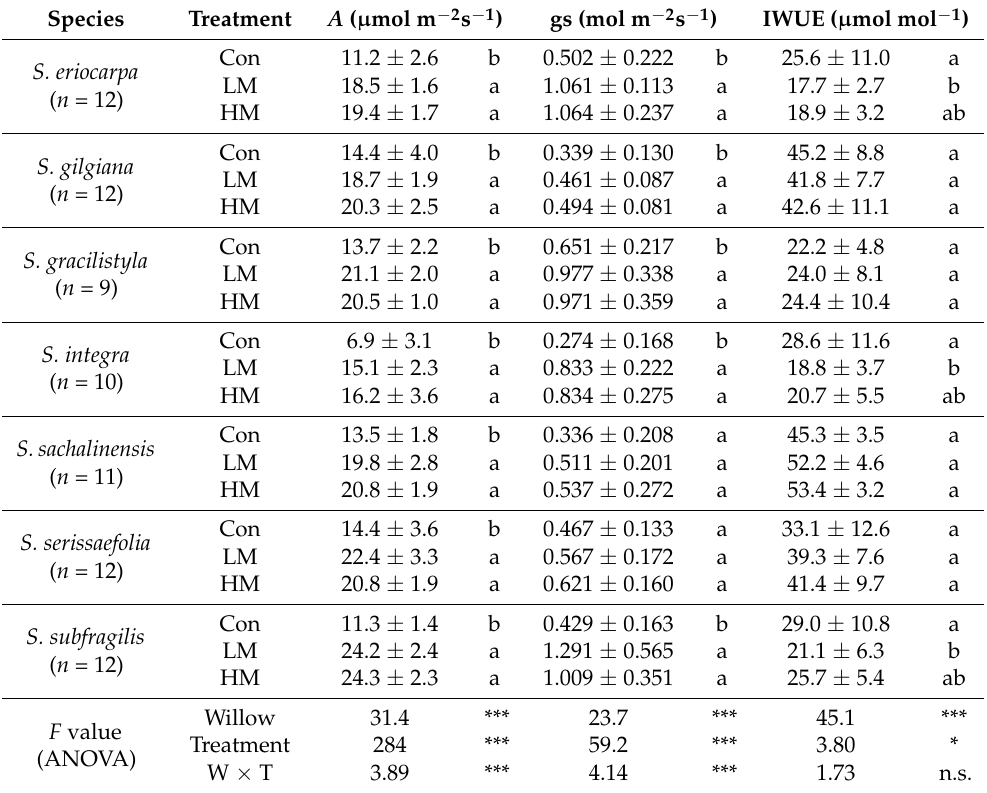
Table 4. Photosynthetic rate at light saturation ( A ), stomatal conductance (gs) and intrinsic water use efficiency (IWUE) of the leaves of individuals of seven willows grown under three treatments (mean ± SD). Asterisks indicate significant differences among seven willows, three treatments, and their interaction (W × T) calculated by ANOVA. * = p < 0.05 and *** = p <